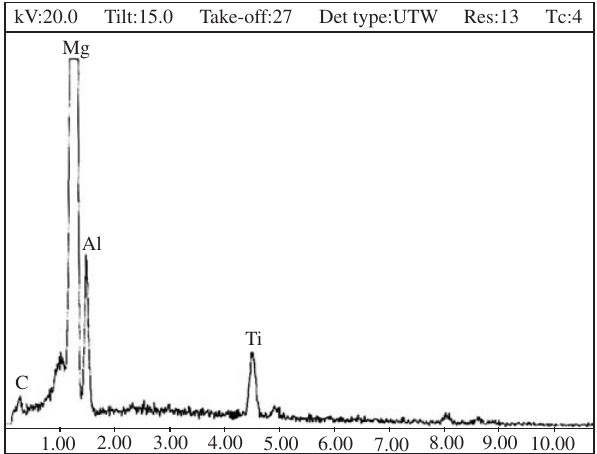
Figure 4. EDX analysis of magnesium matrix